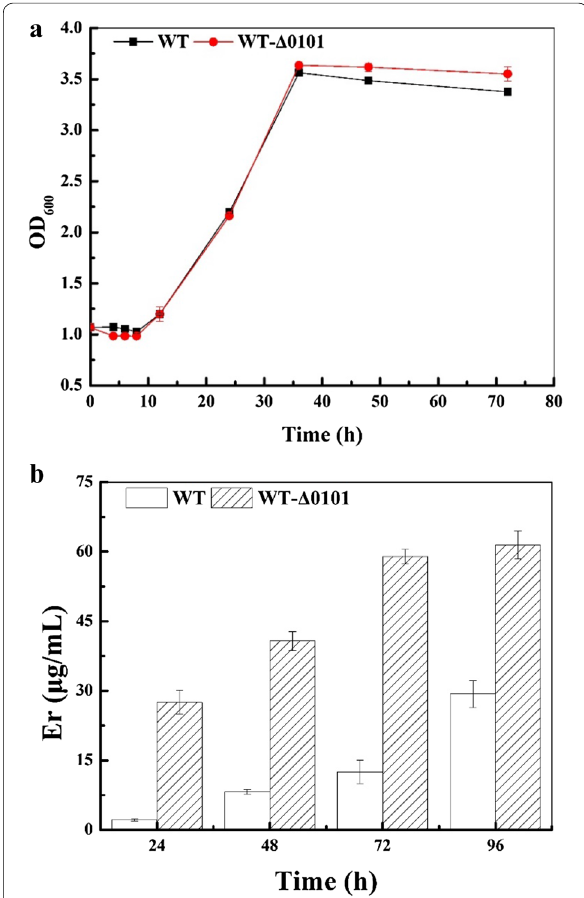
Fig. 3 Time course of OD 600 ( a ) and erythromycin production ( b ) in wild-type strain WT (white square) and mutant strain WT-Δ0101(square with upper right to lower left fill)